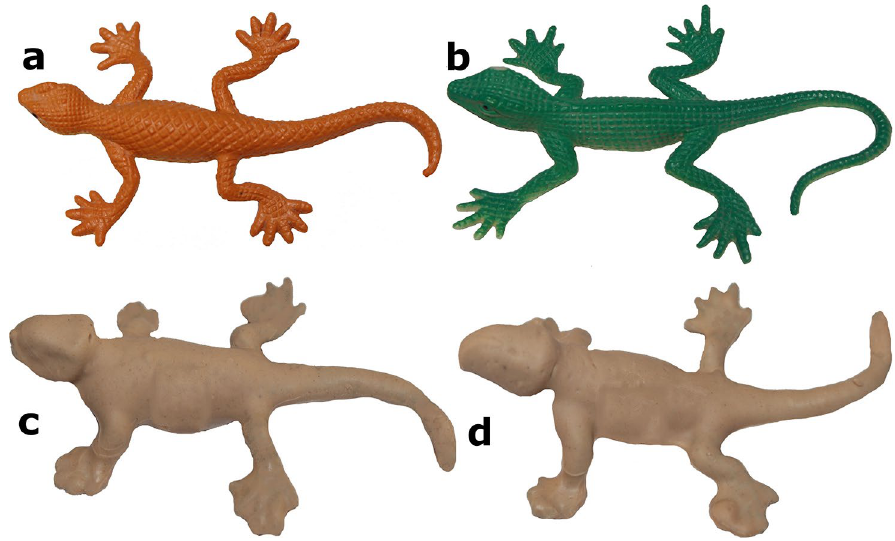
Figure 4. Artificial lizard replicas (8 x 75 mm) used in the field predation experiments. ( a , b ) Original replicas made of flexible plastic. ( c , d ) Replicas manually covered with brown-colored non-toxic modelling clay (plastiline). All photographs taken by Anthony